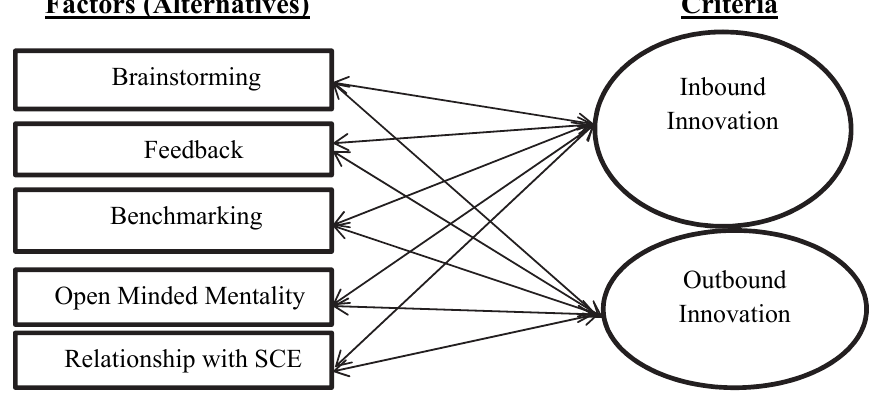
Fig. 1. Factors and Criteria of the Model